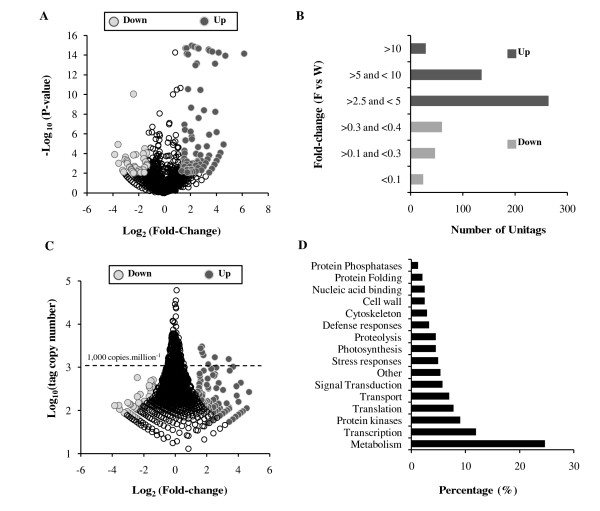
Analysis of differentially expressed UniTags. A, Volcano plot showing the Log2(fold-change; F vs. W) versus Log10(P-value) of 547 expressed UniTags. B, Fold change (F vs. W) distribution of the 547 differentially expressed UniTags. C, Distribution of the expressed UniTags based on the Log2(Fold-change; F vs. W) versus Log10(tag copy number). The dashed line corresponds to a threshold of 1,000 copies.million-1. D, Distribution of 242 annotated UniTags in Gene Ontologiy (GO) categories based on Molecular Function and Biological Process.